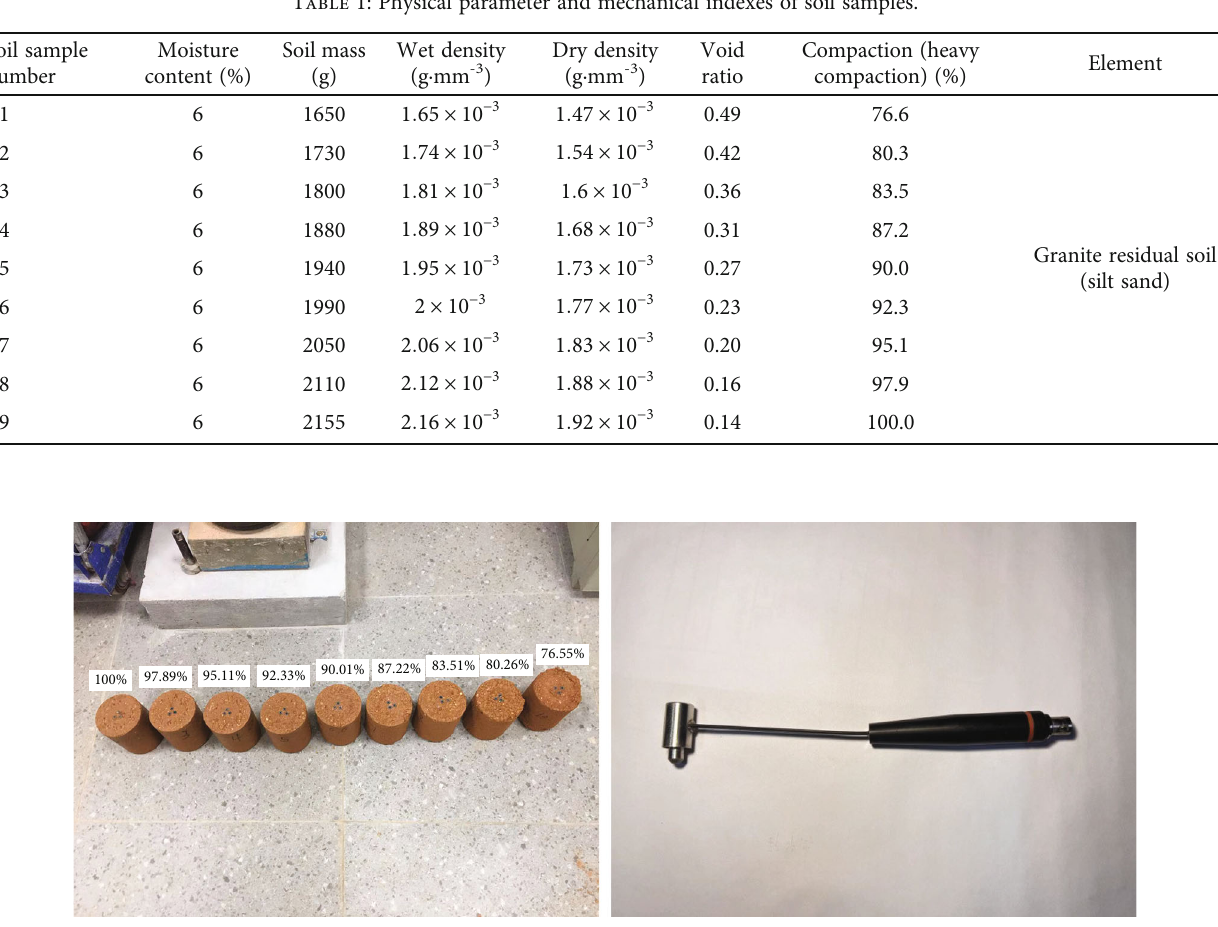
Figure 1: Hammering diagram of indoor soil sample and force